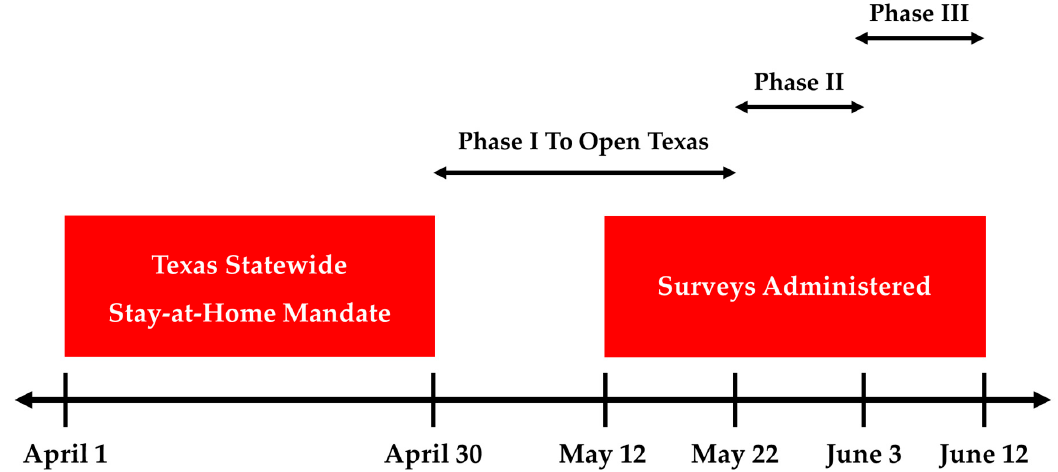
Figure 1. Survey data collection timeline and Texas statewide mandates in response to COVID-19, and phased openings. Phase I: restaurants permitted to open at 25% capacity [41] . Phase II: restaurants permitted to open at 50% capacity. Bars and bowling alleys permitted to open at 25% capacity. Gyms, offices, and manufacturing businesses permitted to open at 25% capacity on May 18 [42] . Phase III: all businesses permitted to open at 50% capacity. Restaurants permitted to open at 75% capacity [43] .